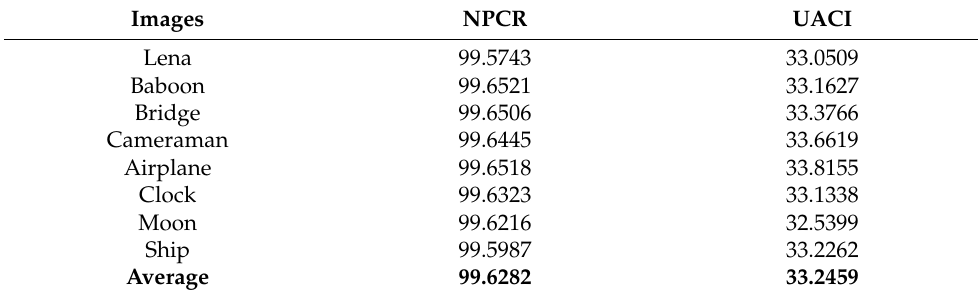
Table 4. The calculated average values of NPCR and UACI for different images.